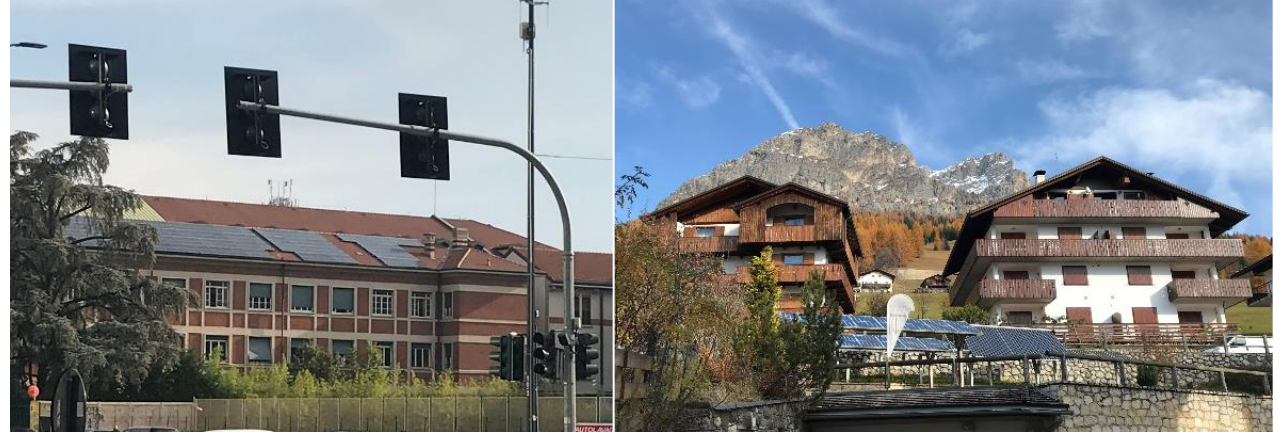
Figure 9. Negative examples of the “ recognizability ” criteria of the solar intervention in a XX Century School in Milan (Italy) and in traditional alpine buildings in Val Sarentino (Italy) where PV and ST panels are visible from public spaces for their irregular shapes, blue colors, and high reflectance (Source: Elena Lucchi).